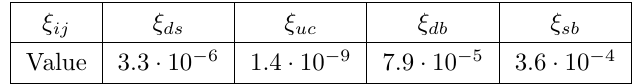
Figure 13 . Diagrams of the production of the scalar S in (cid:13)avor changing quarks transitions in the unitary gauge.